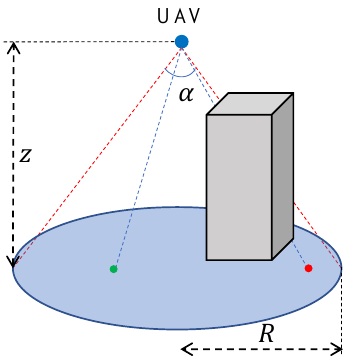
Figure 1. The observation of the ground-facing camera. The target at the green point can be viewed by the unmanned aerial vehicle (UAV) while that at the red point cannot due to the blockage of the building.